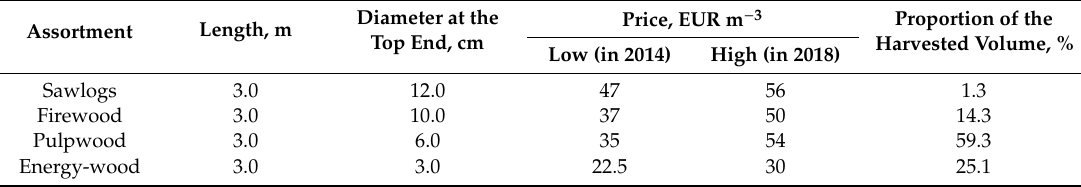
Table 1. Assortment classes by diameter at the top end and monetary value with low and high timber